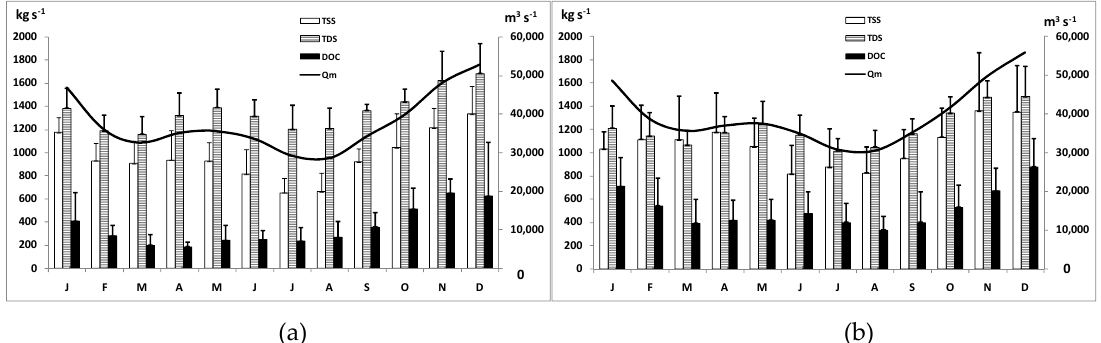
Figure 6. The annual variation of interannual monthly fluxes of total suspended sediment (TSS), total dissolved solid (TDS) and dissolved organic carbon (DOC) at the Congo River outlet, related to the interannual monthly discharge (Qm), from ( a ) 1987–1993, and ( b ) 2006–2017.